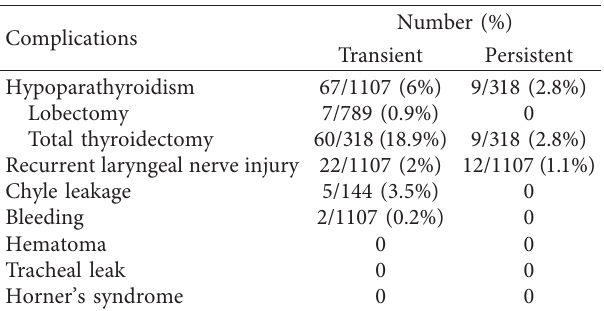
Table 2: Postoperative